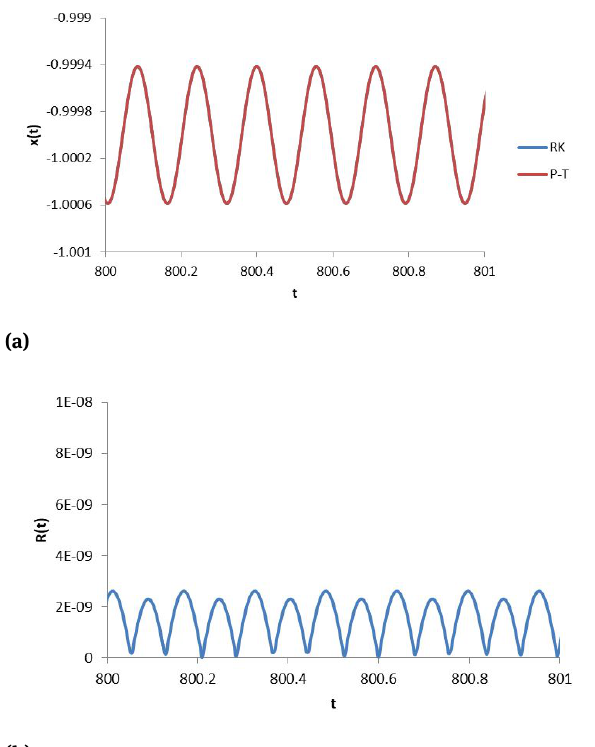
Figure 1: a) Numerical results of P-T and Runge-Kutta method ( dt = 0.005, r =0.935, ω =40, k =0.5, x (0) =-1.0, ˙ x (0) =-1.0); b) Comparison of P-T and Runge-Kutta method ( dt = 0.005, r =0.935, ω =40, k =0.5, x (0) =-1.0, ˙ x (0)